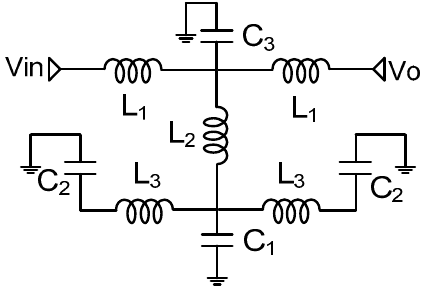
Figure 3. Lumped-element circuit (LC) model for the bent T-shaped resonator.